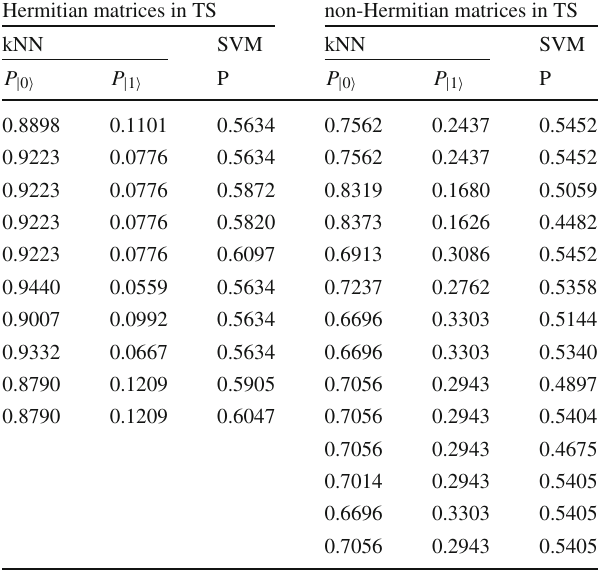
Table 1 Results of pattern recognition for quantum versions of kNN and SVM methods Hermitian matrices in TS non-Hermitian matrices in TS